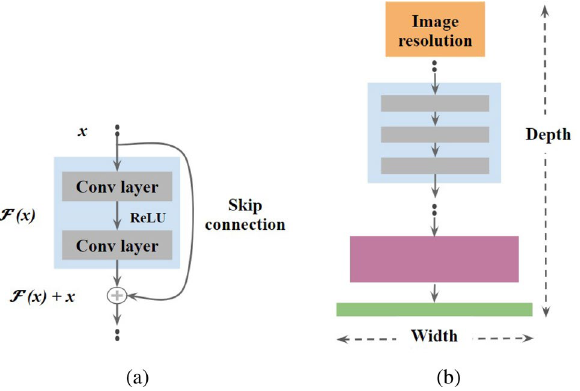
Figure 6. Frameworks in DL models: ( a ) Residual block; ( b ) Compound scaling.